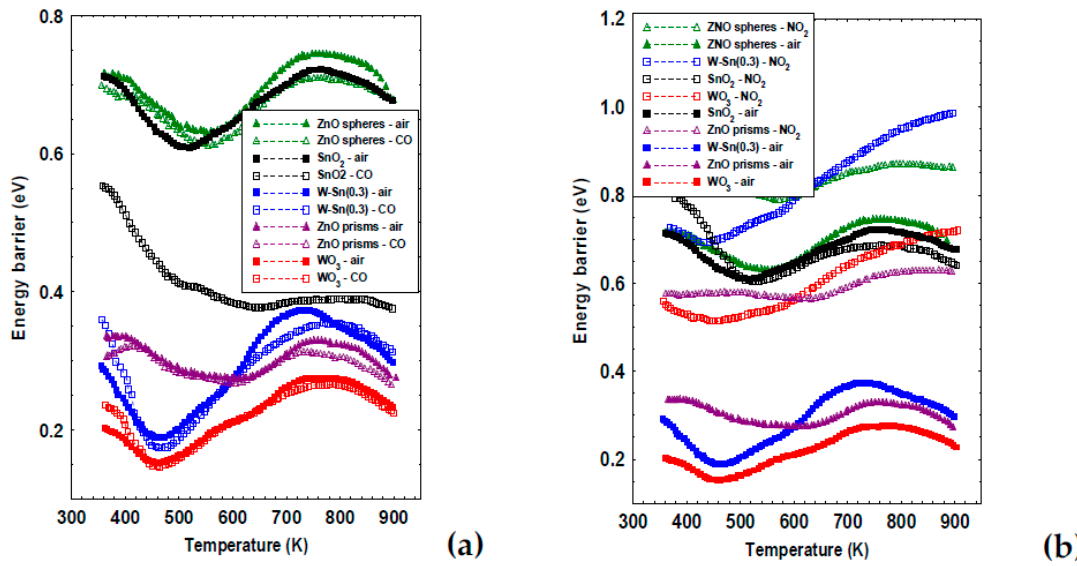
Figure 4. ( a ) Comparison between the energy barriers in dry air and in 100 ppm of CO; ( b ) in dry air and in 10 ppm of NO 2 .